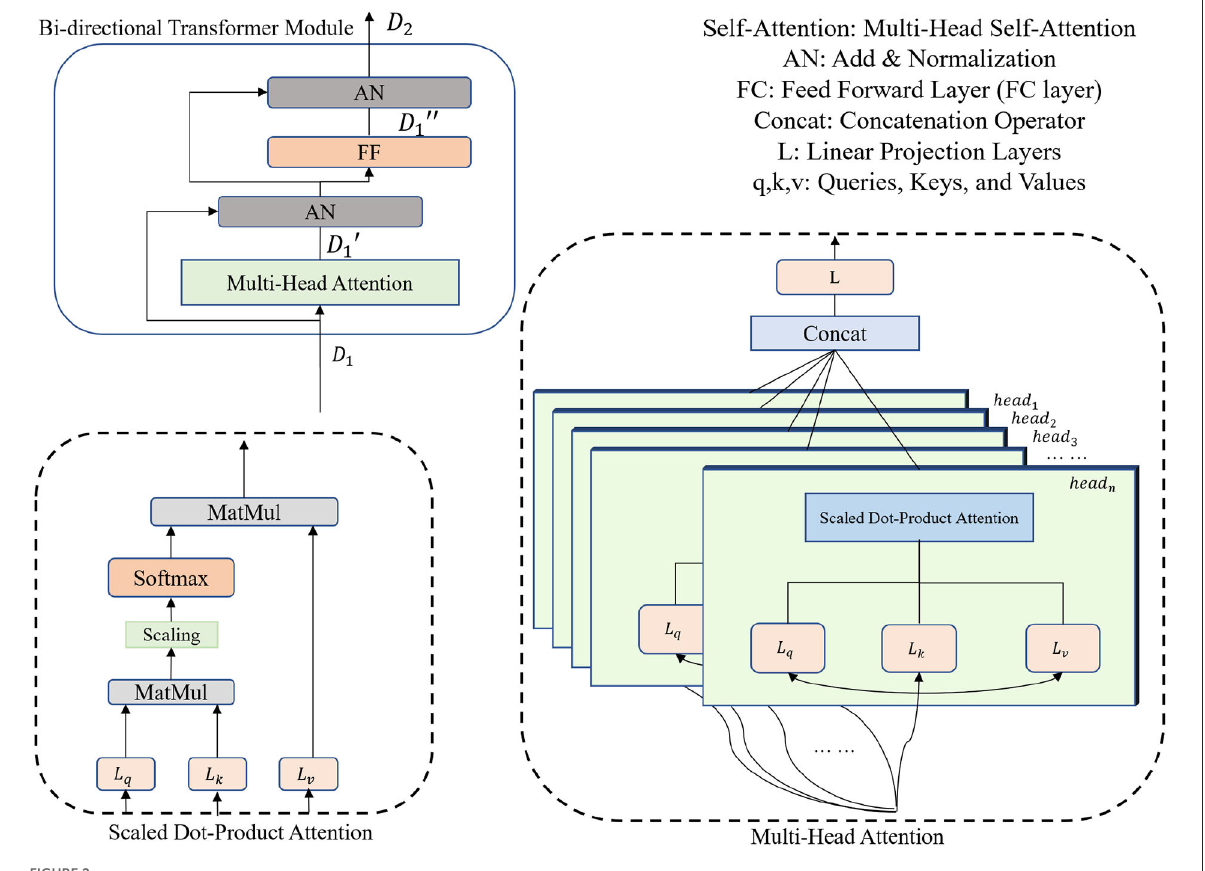
FIGURE2 Encoder Part II: bi-directional transformer with a multi-head attention